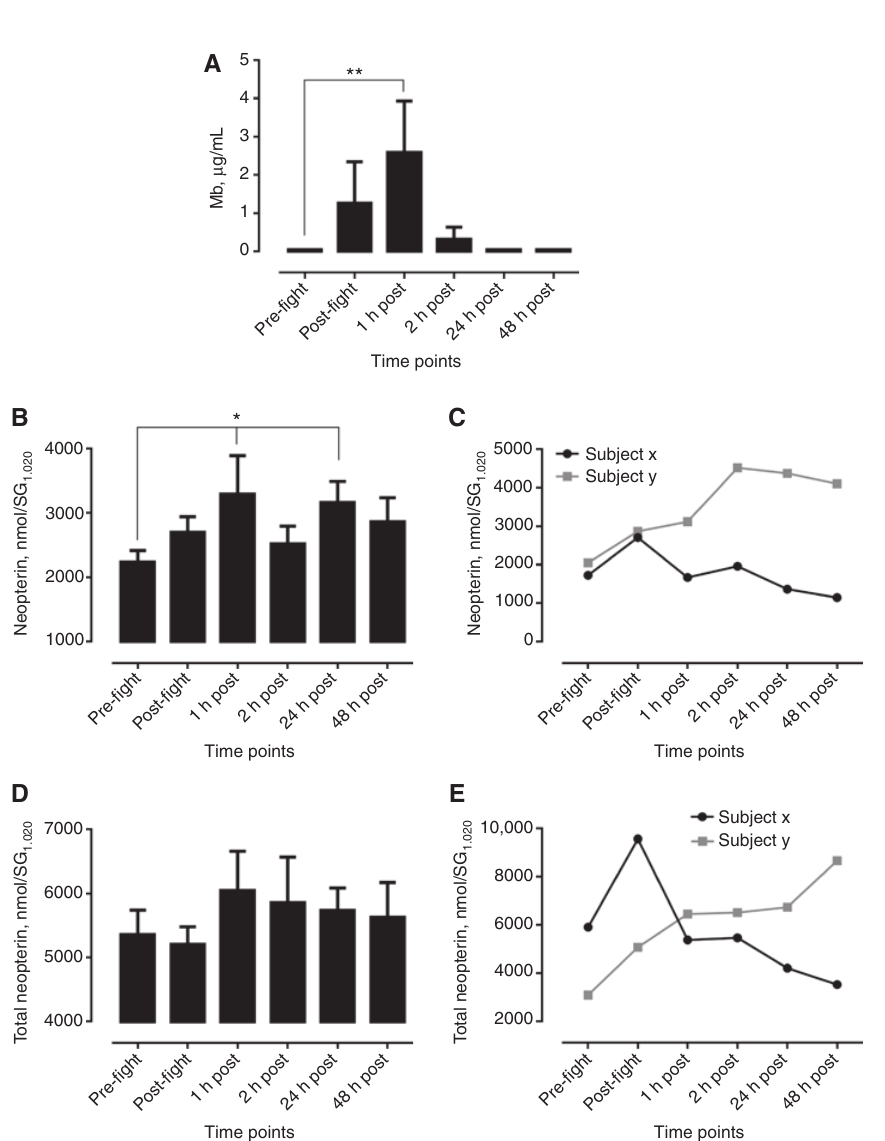
Figure 1: Urinary myoglobin (A), urinary neopterin (B), urinary neopterin of selected individuals with a varied response (C), urinary total neopterin (D) and urinary total neopterin of selected individuals with a varied response (E). Data are presented as the mean ± standard error of the mean (SEM). *p < 0.05, **p <